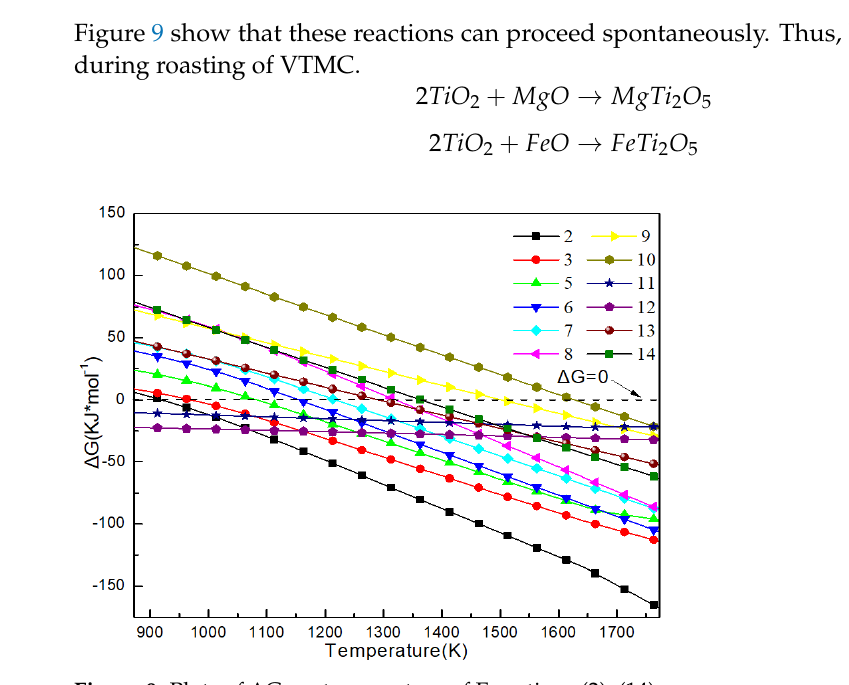
Figure 9. Plots of ∆ G vs. temperature of Equations